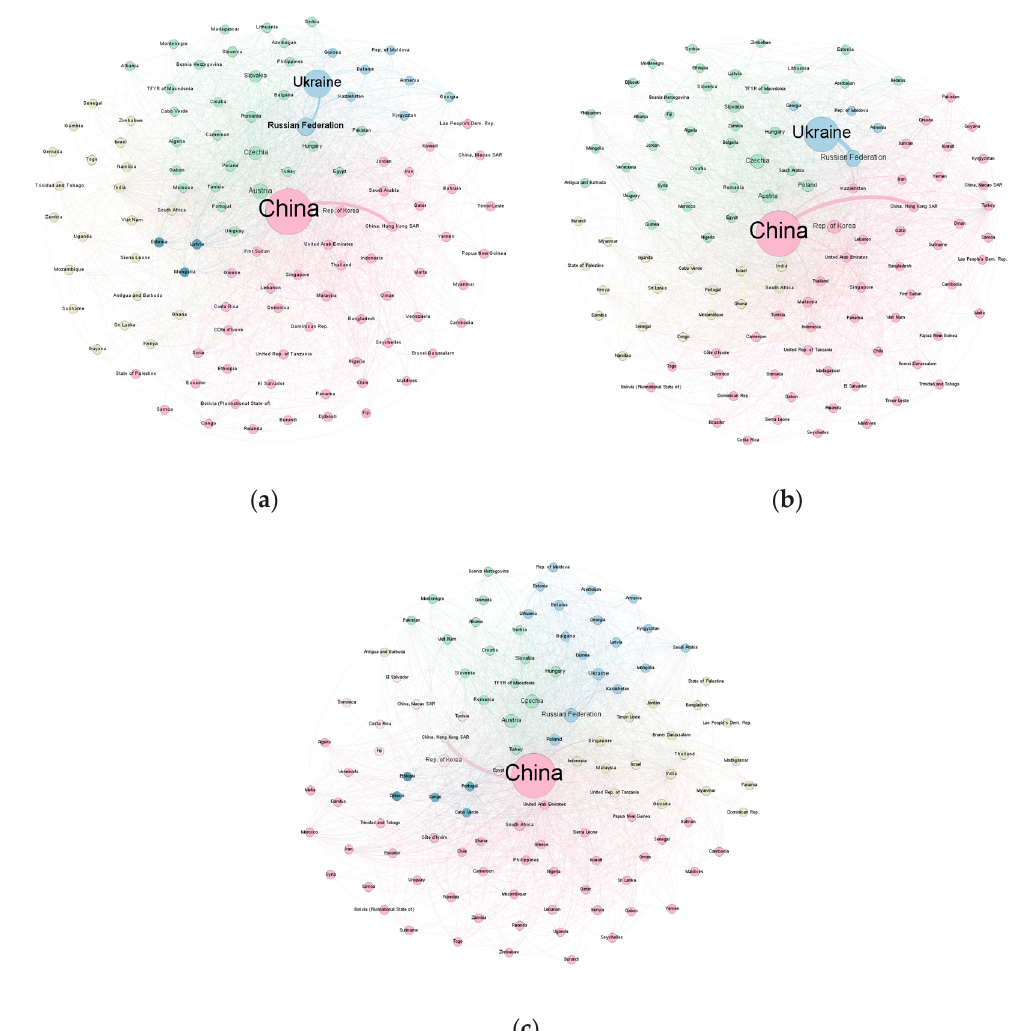
Figure 5. Trade networks of rolling stock products in the BRI region: ( a ) phase 1 (2003–2008), ( b ) phase 2 (2009–2013), and ( c ) phase 3 (2014–2017). The size of the node indicates the strength centrality. Each community is indicated by its given color. The diameter of the edge represents the volume of the trade flow.